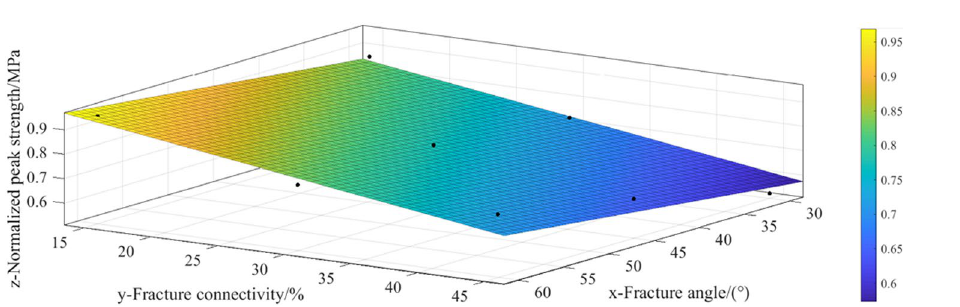
Figure 9. Fitting surface of the peak strength of fractured soft